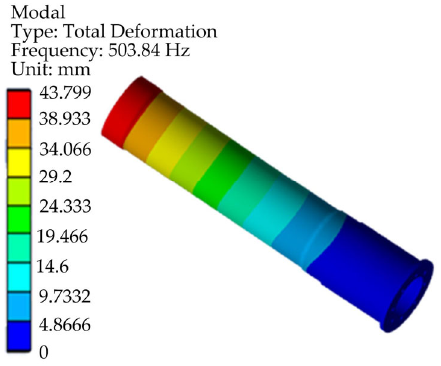
Figure 14. Total deformation of the small arm under the first-order modality. Table 6. Frequencies for the di ff erent modality shapes.